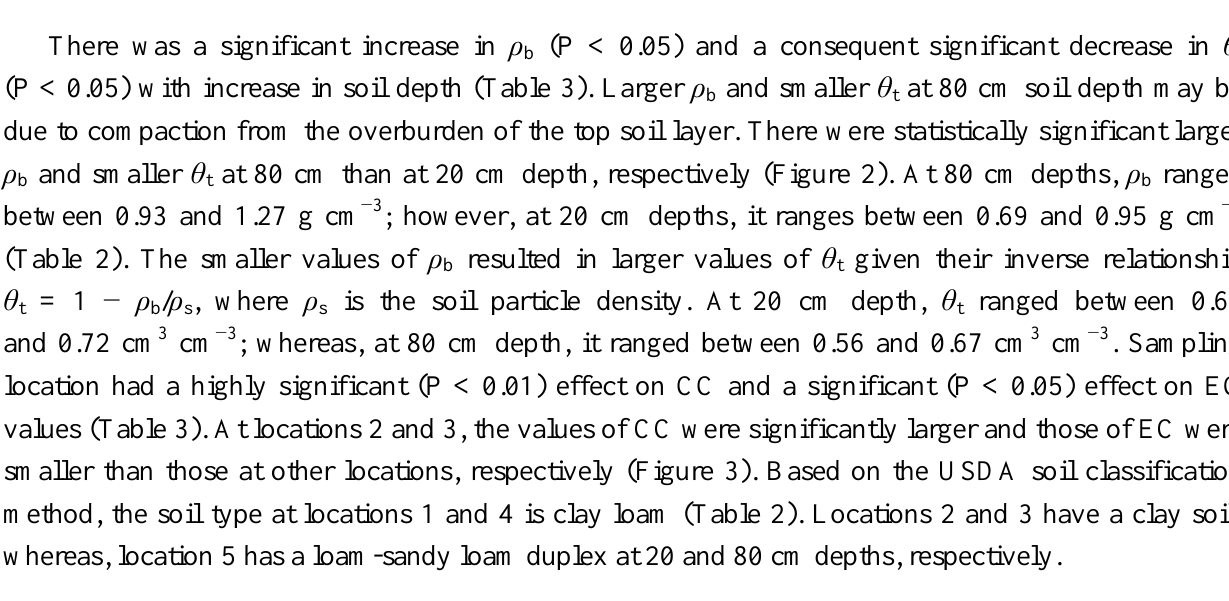
Table 3. Values of the probability (P) and significance levels obtained from the factorial general analysis of variance for bulk density (  electrical conductivity (EC) as a function of soil depths and sampling